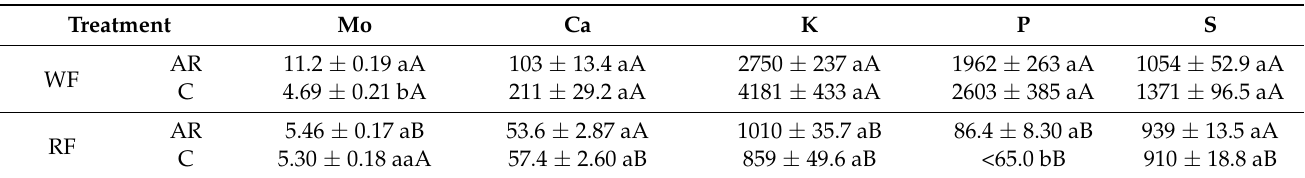
Table 1. Average values (mg · kg − 1 ) ± standard deviation ( n = 4) of Mo, Ca, K, P, and S in the whole (WF) and refined flours (RF) of Oryza sativa L. varieties Ariete (AR) and Ceres (C) at harvesting. Different letters indicate significant differences between varieties in the same flour (letters a and b) and between different flours in the same variety (letters A and B) ( p ≤ 0.05).